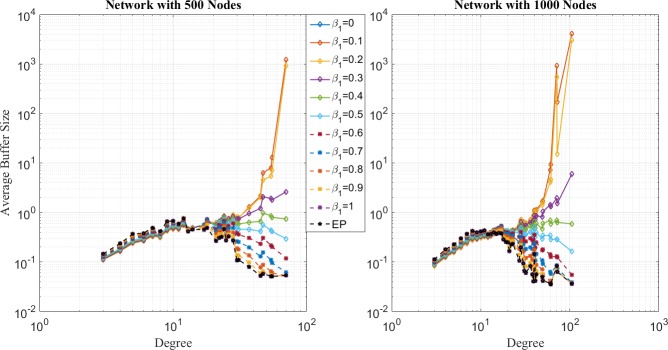
Relationship between average buffer size and node degree for different routing strategies on networks with 500 nodes (left figure) and 1000 nodes (right figure) in low traffic case.